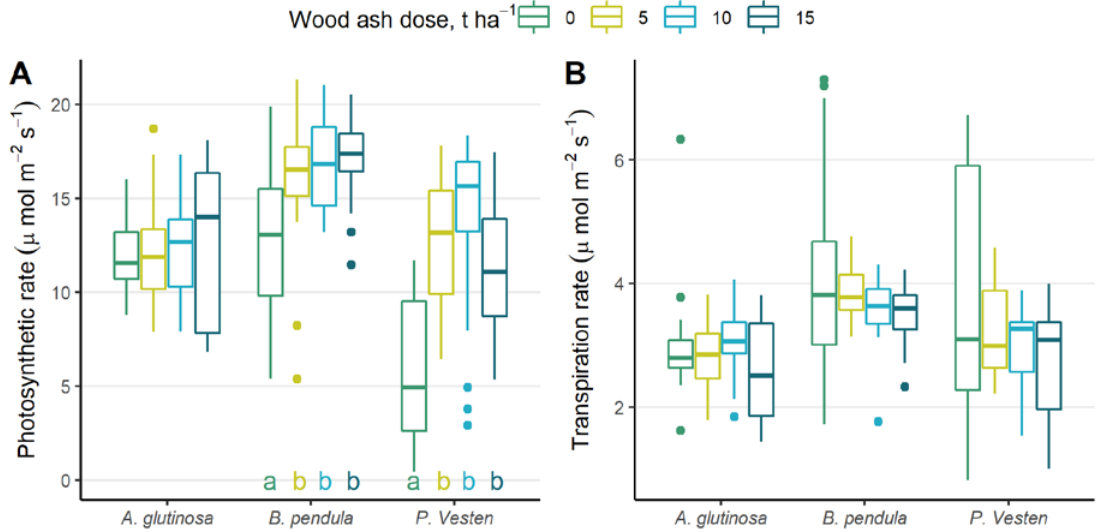
Figure 6. Studied tree species traits. (A) photosynthetic rate (B) transpiration rate. Letters denote significant (p adj . < 0.05) value difference between fertiliser dose for one